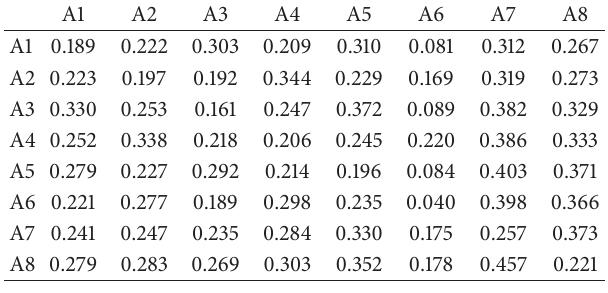
Figure 15: Driving power-dependence diagram of model